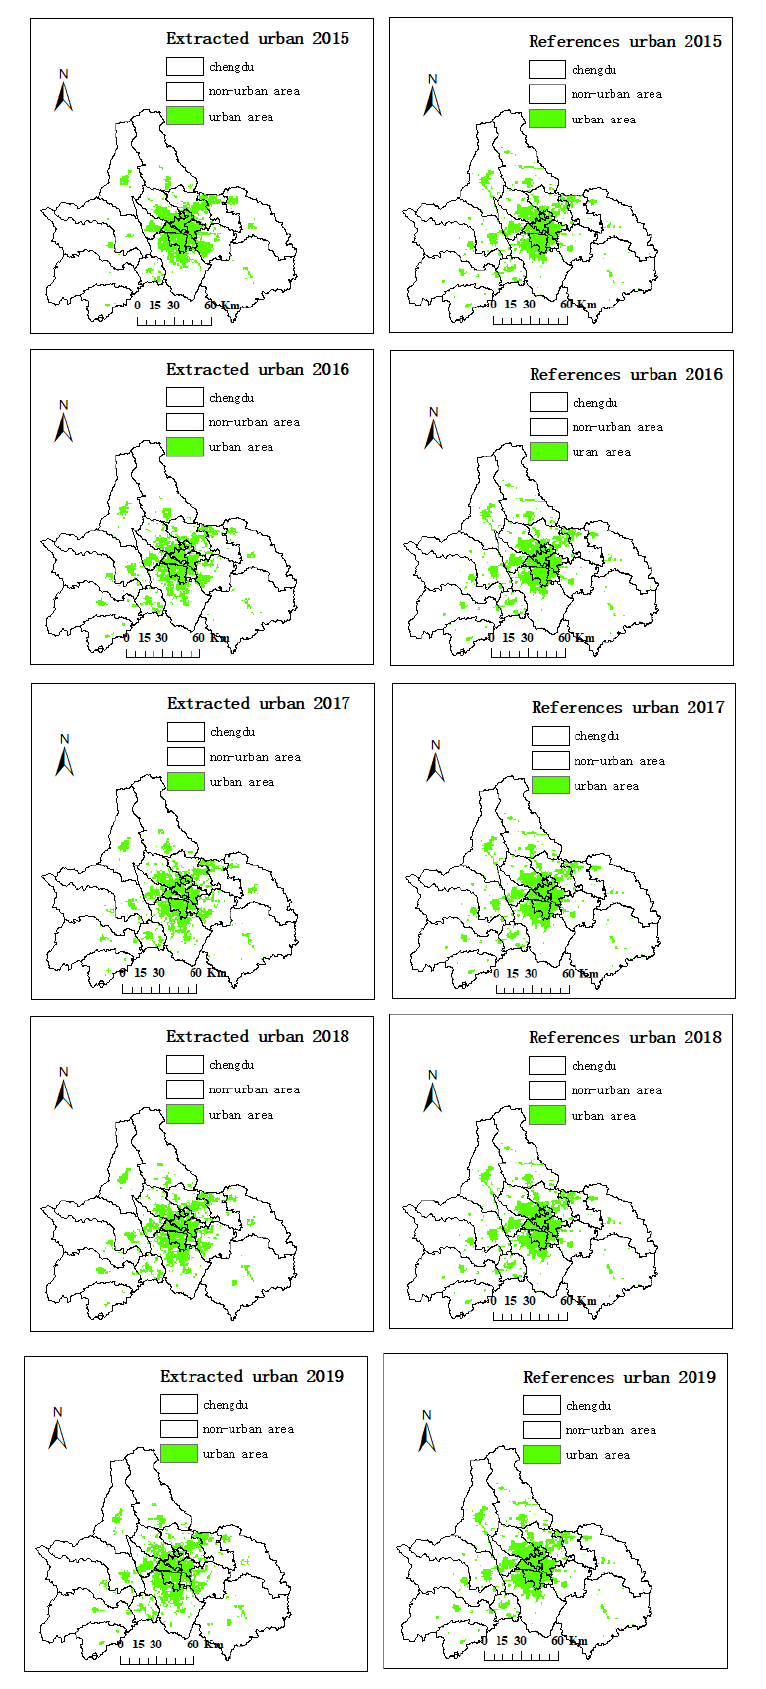
Figure 4. Urban built-up area change of